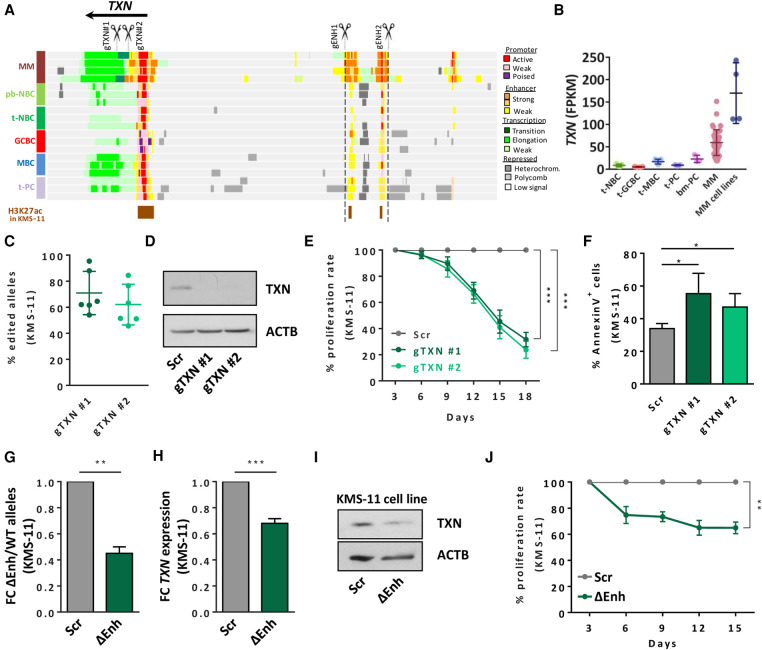
TXN de novo activated enhancer as an essential regulatory element in MM. (A) Genome browser snapshot of the TXN locus and the associated enhancer de novo activated in MM located at 50 kb from the promoter region. Displayed tracks represent the chromatin state annotation in MM patients and normal B cells and an additional track of H3K27ac peaks in KMS-11 cell line (ENCODE Consortium, ENCSR715JBO). gRNA design strategy for TXN knockout and enhancer deletion is also shown. (B) TXN expression in MM patients and cell lines analyzed by RNA-seq. (C) Estimation of the allelic cell population percentage exhibiting indel events in the targeted site, analyzed by Tracking of Indels by DEcomposition (TIDE) web tool. (D) Validation of TXN reduced expression by western blot analysis in KMS-11 cell line. (E) Cell proliferation assay comparing the growth proliferation rates of scramble cells (Scr) and cells harboring two different gRNAs, as determined by flow cytometry analysis. (F) Effect of TXN reduced expression in cell apoptosis, as determined by Annexin V flow cytometry analysis. (G) Quantification of TXN enhancer deletion by genomic DNA qPCR normalized to a distal nontargeted genomic region, represented as fold change of deleted enhancer (ΔEnh) versus wild-type (WT) alleles. (H) TXN mRNA expression levels determined by RT-qPCR. (I) TXN protein levels in cells with deleted enhancer region (ΔEnh) and scrambled cells (Scr) determined by western blot. (J) Cell proliferation assay comparing the growth proliferation rates of scramble cells and cells harboring the enhancer deletion (ΔEnh), as determined by flow cytometry analysis. (*) P < 0.05, (**) P < 0.01, (***) P < 0.001.